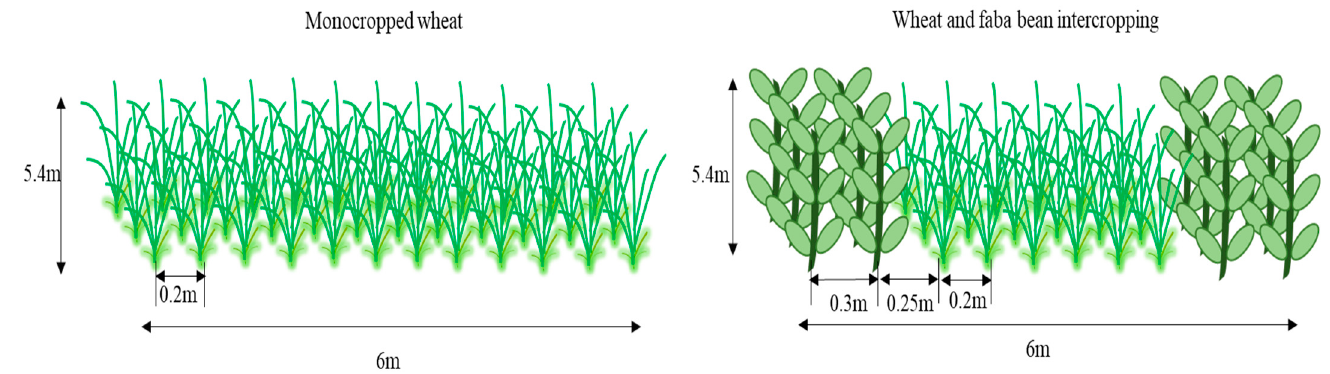
Figure 2. Diagram of the planting pattern for wheat and faba bean intercropping and mono-cropped wheat in the field experiment.